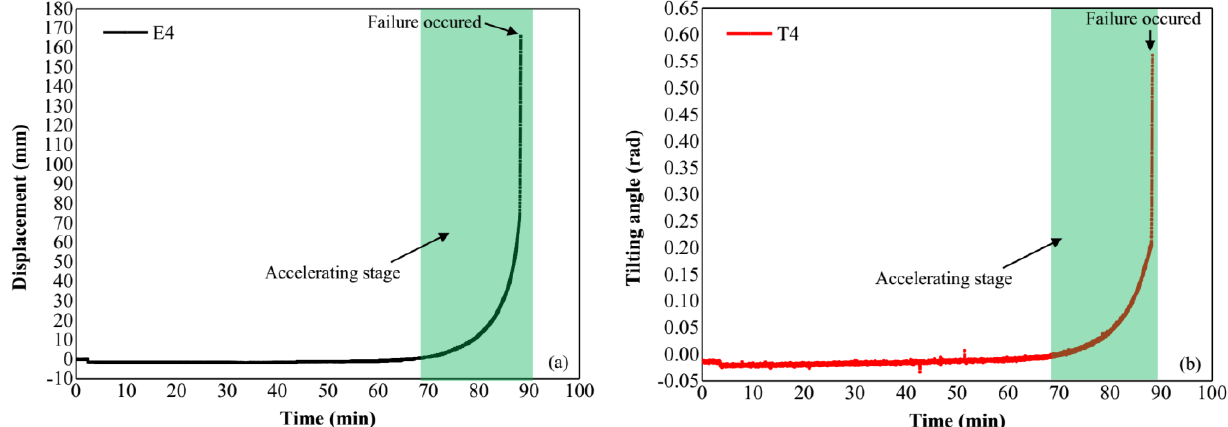
Figure 12. ( a ) Reciprocal displacement rate against time, ( b ) reciprocal tilting rate against time.